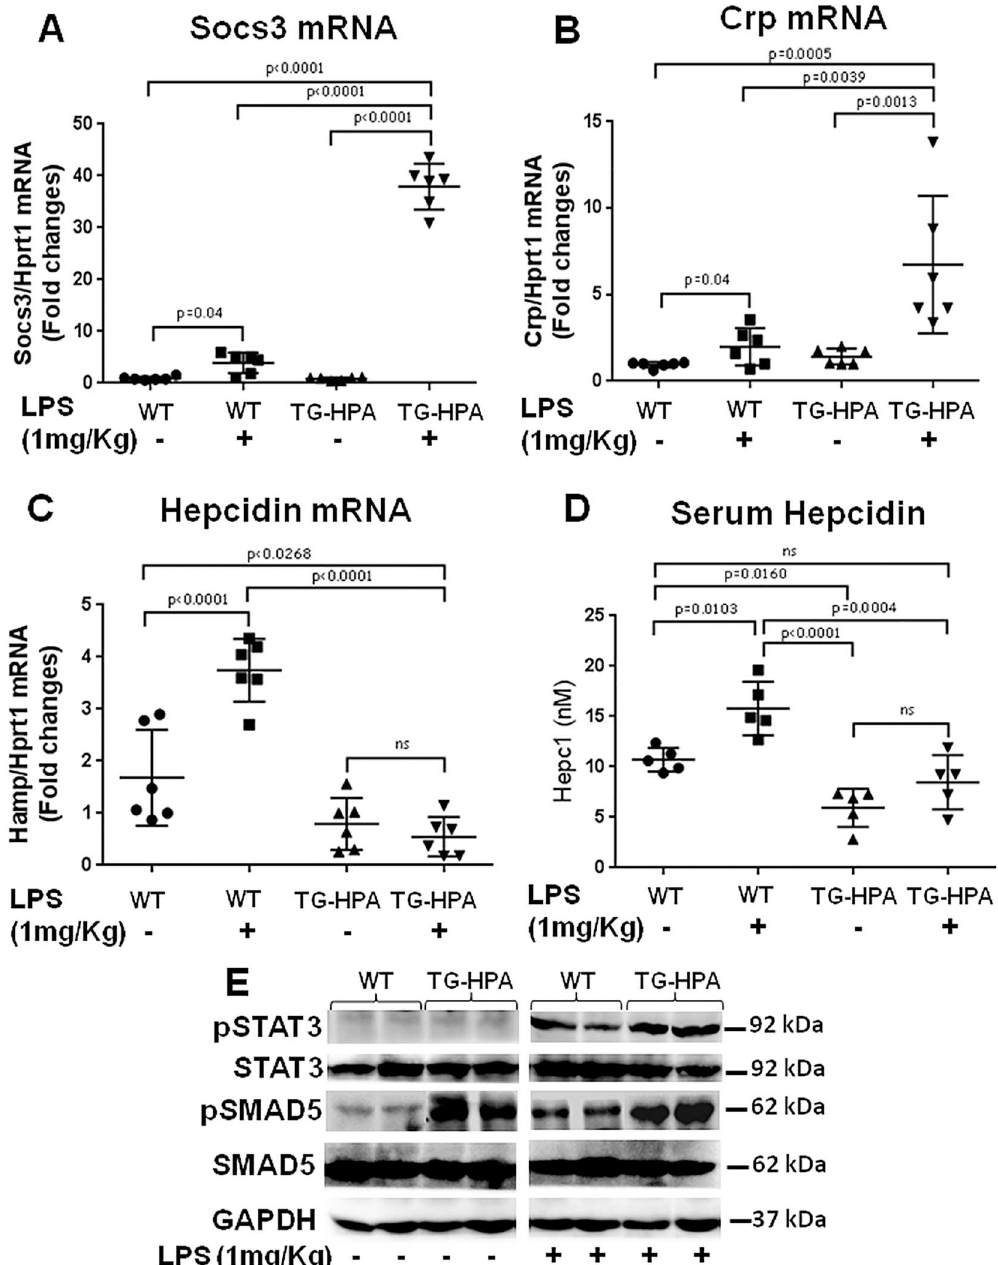
Fig 8. Transgenic mice overexpressing Heparanase are more sensitive to inflammatory stimuli. WT and TG-HPA mice were treated with a single dose of LPS (1 mg/Kg) IP and sacrified after 6 h. (A) Analysis of Socs3 mRNA, (B) CRP mRNA and (C) HAMP1 mRNA in the liver of WT and TG-HPA mice in relationto Hprt1, before and after the treatment. The values are expressed as fold changeof wild type mice. (D) Quantification of serum Hepcidinby SELDI-TOF. (E) Western blot of pSMAD5, total SMAD5, pSTAT3, total STAT3 and of GAPDH as